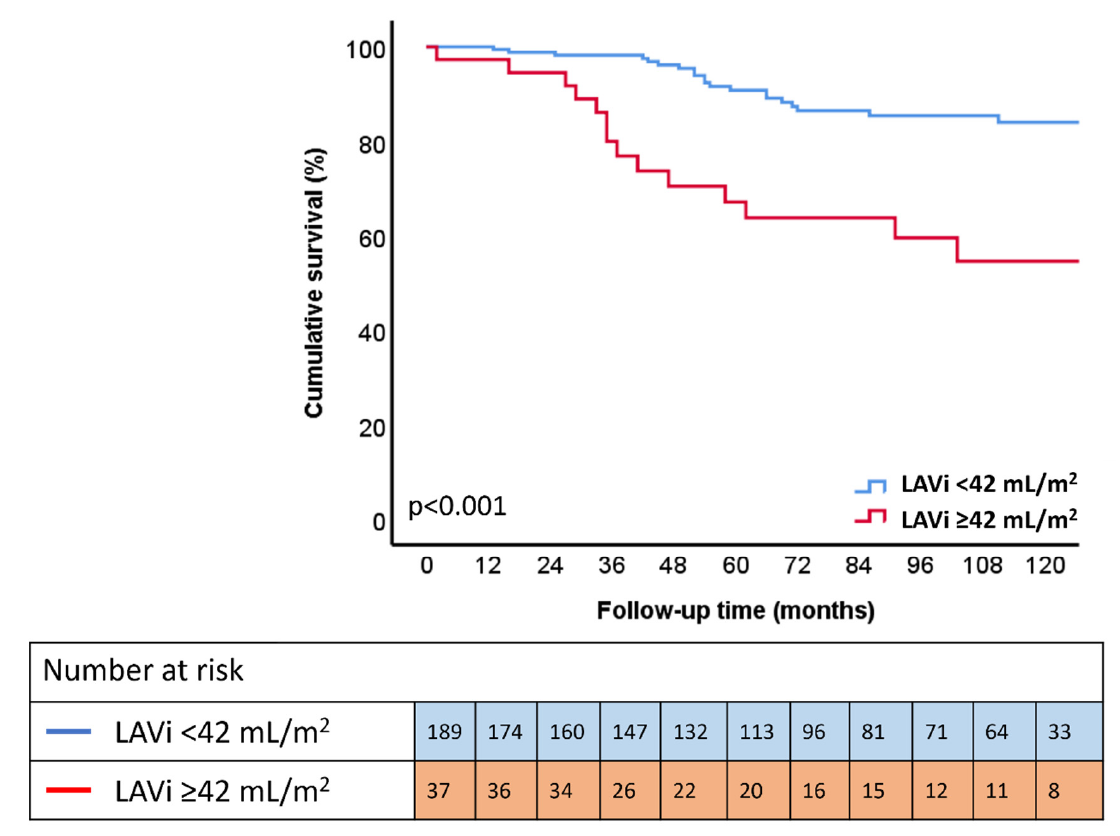
Figure 4. Kaplan–Meier survival curve for all-cause mortality according to LAVi at long-term follow-up. Time to all-cause mortality according to LAVi at long-term follow-up: LAVi < 42 mL/m 2 (blue) and LAVi ≥ 42 mL/m 2 (red). Table 4. Cox regression analysis for all-cause mortality, starting from the long-term follow-up